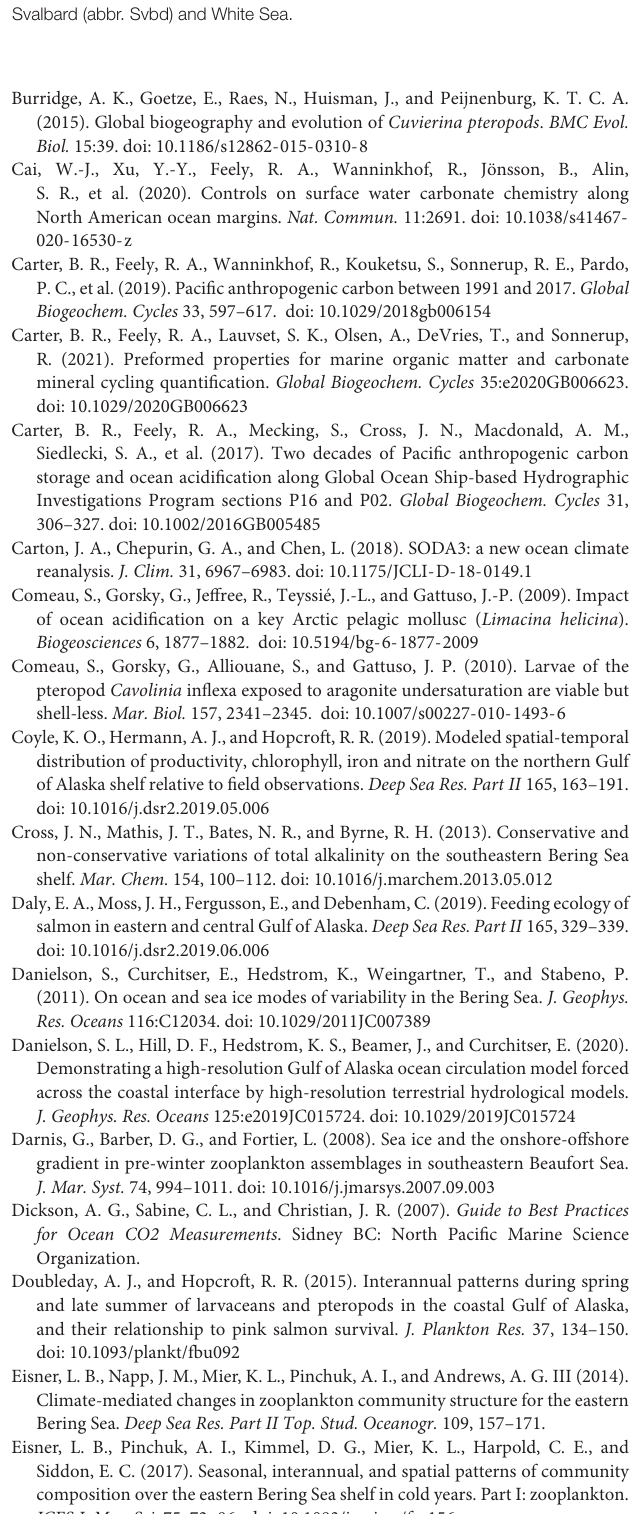
between groups below the diagonal, standard error estimate(s) derived from 500 bootstrap replicates are above the diagonal. Supplementary Table 5 | Estimates of Evolutionary Divergence (p-distance) between regions. The number of base differences per site from averaging over all